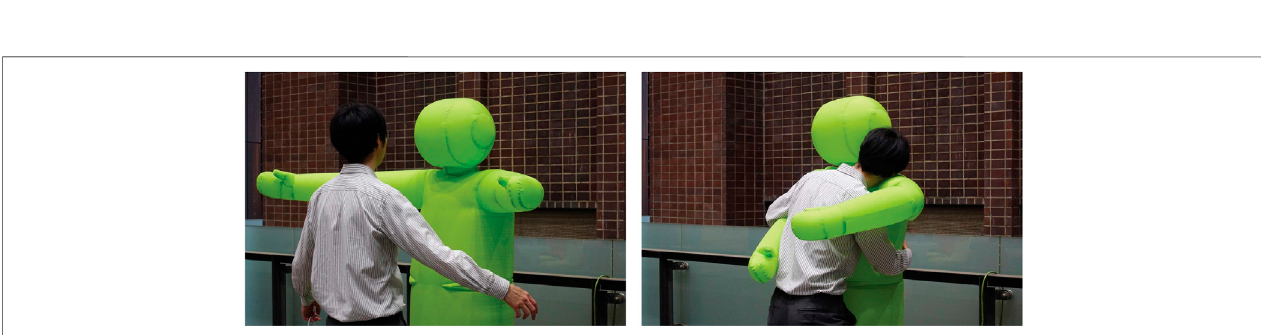
FIGURE 12 | In fl atable hug